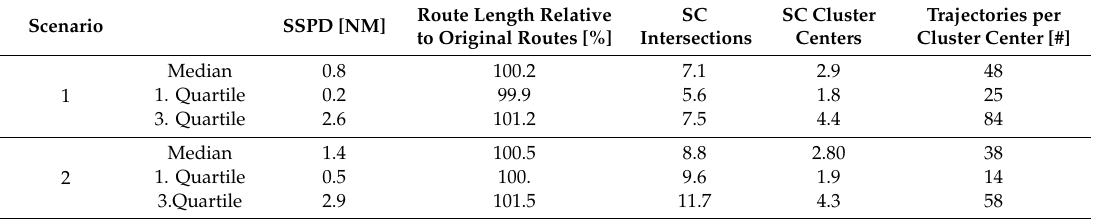
Table 5. Main-flow key data for both scenarios (reduced main-flow